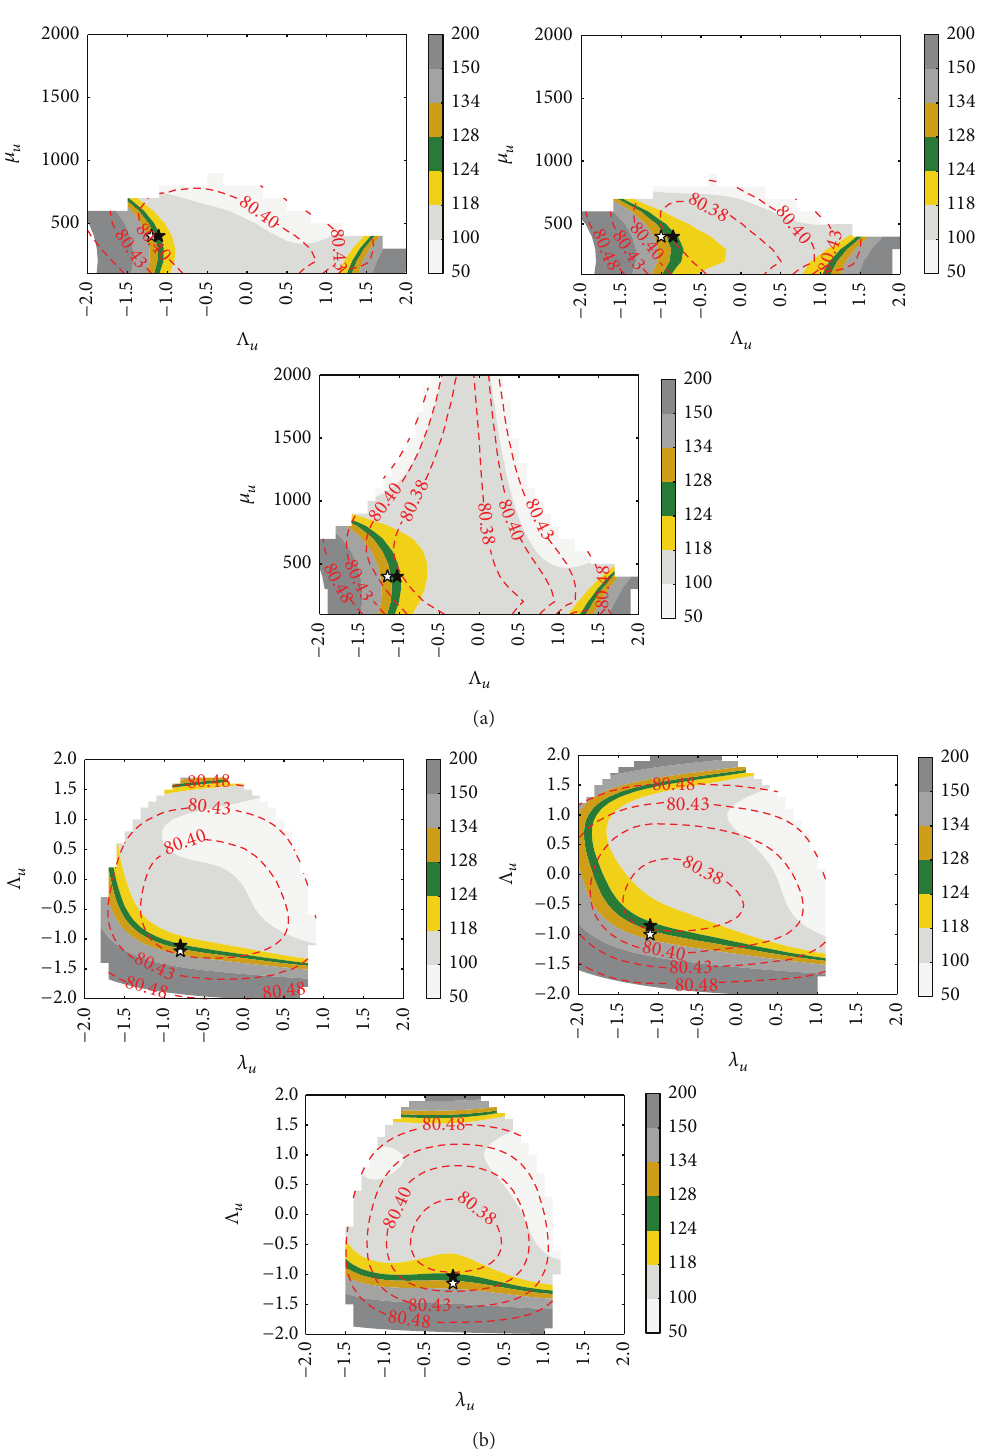
Figure 6: Contour plots showing the behavior of 𝑚 𝐻 given by the color map and 𝑚 𝑊 by the red contour lines: (a) for BMP1, (b) for BMP3, 1 for different combinations of model parameters. The white stars mark the original benchmark points from [17], whereas the black ones show the adapted points after taking into account the two-loop